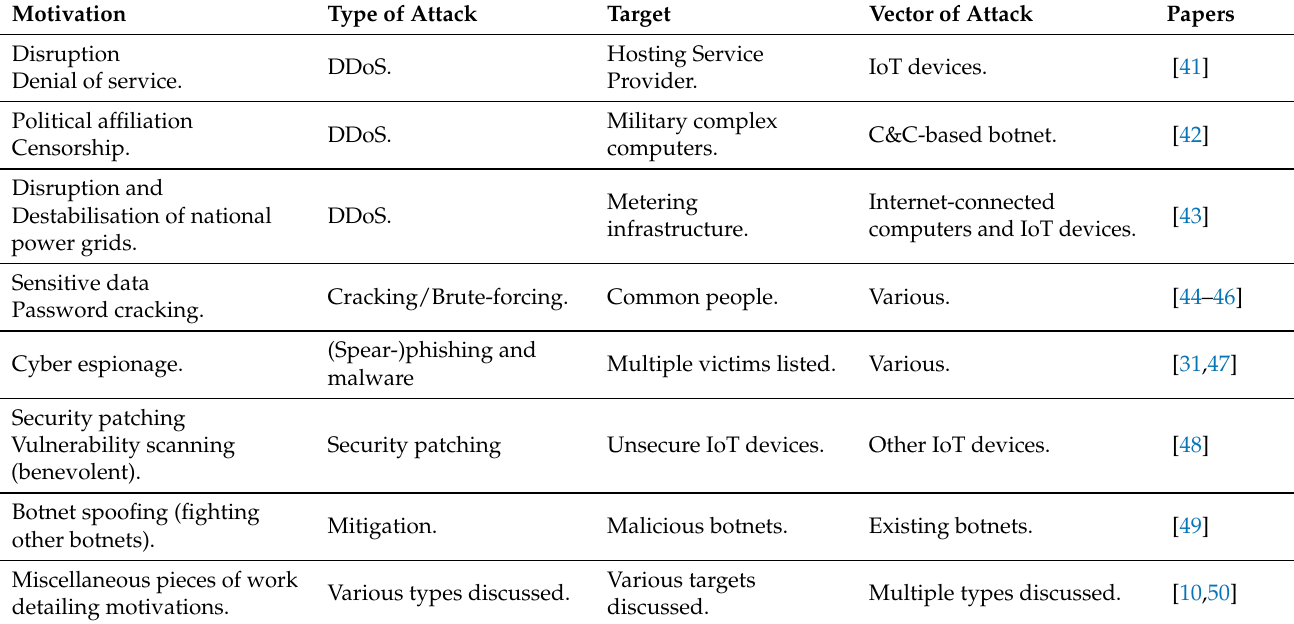
Table 2. Table of motivations behind botnet-based attacks. The columns describe the motivation, type of attack, known affected targets, attack vector(s) and the case study/paper describing the